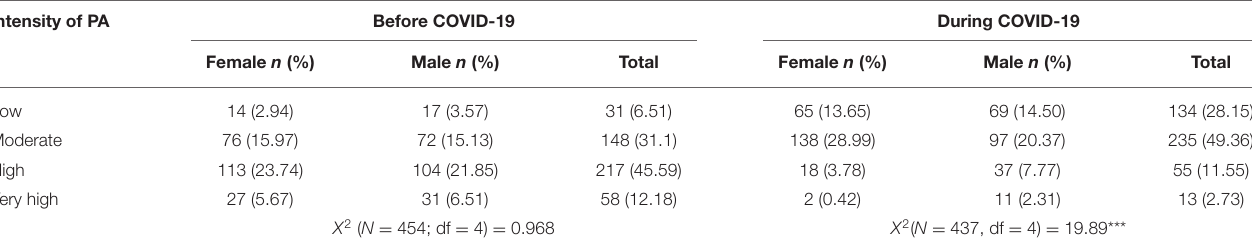
TABLE 2 | Intensity of physical activity (PA) before and during the coronavirus disease 2019 (COVID-19), and separately for female and male participants. Intensity of